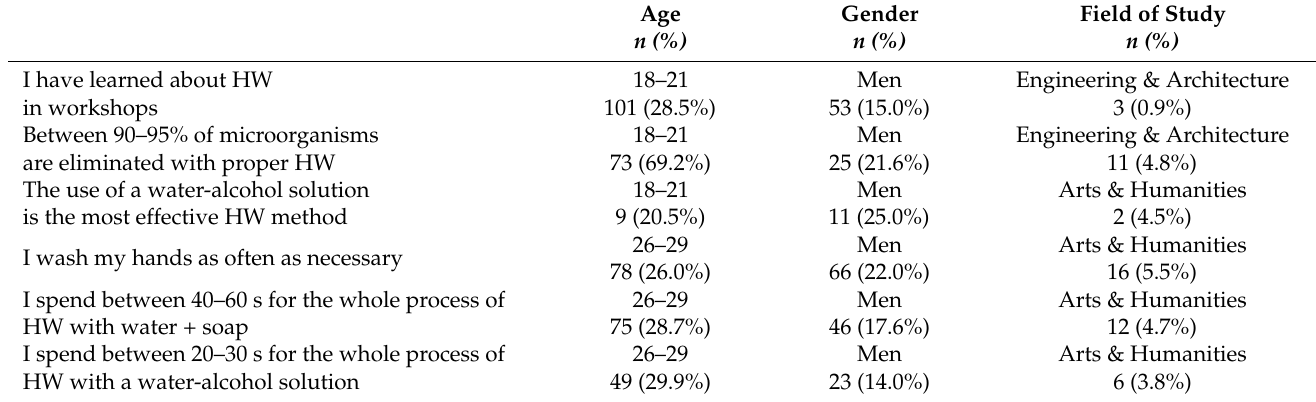
Table 9. Age group, gender and field of study acting as BARRIERS for a proper hand